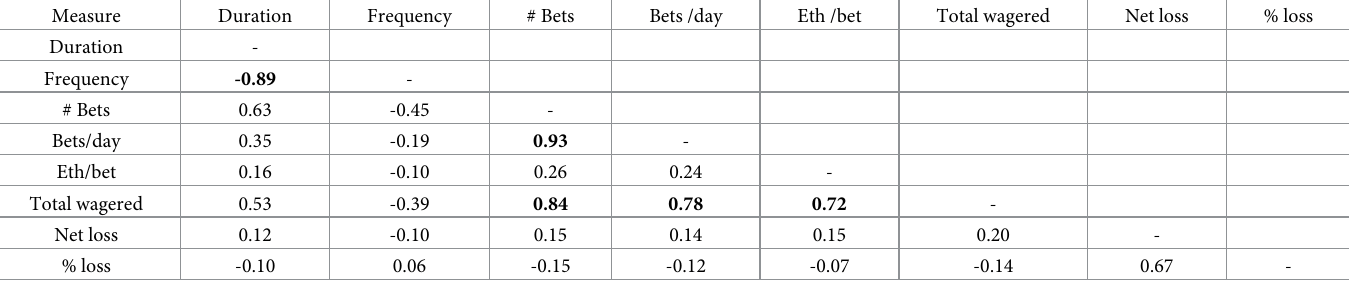
All values are significant at the p < 0.01 level. Coefficients of magnitude greater than 0.70 are